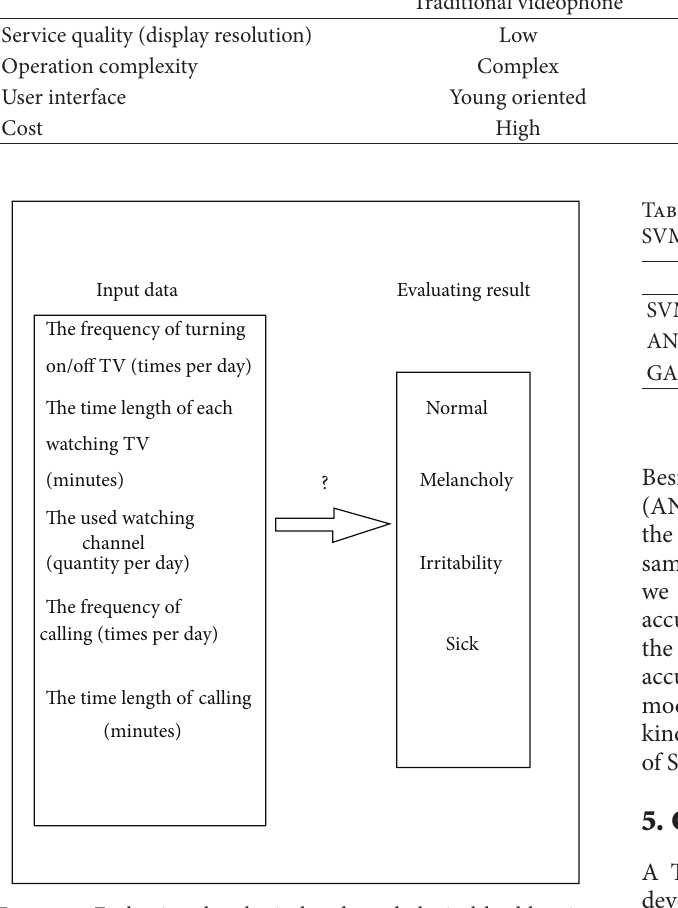
Figure 7: Evaluating the physical and psychological health using TV-using information.